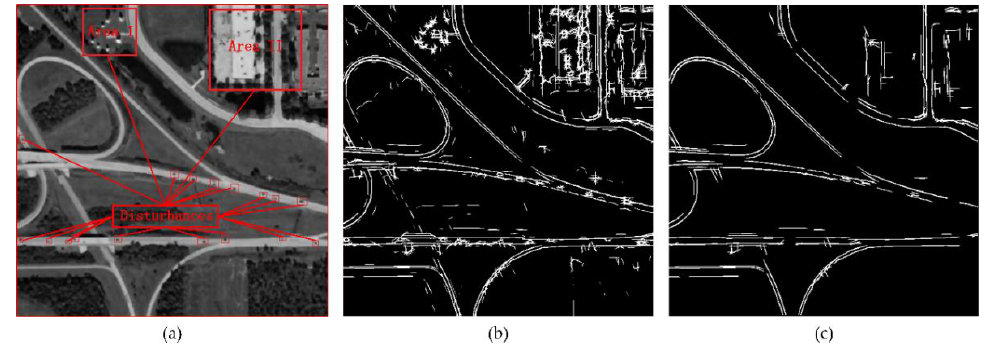
Figure 3. Extraction of Gabor features of interest. ( a ) Original map with many disturbances; ( b ) map of merged Gabor features; ( c ) merged map of Gabor features of interest in each orientation.